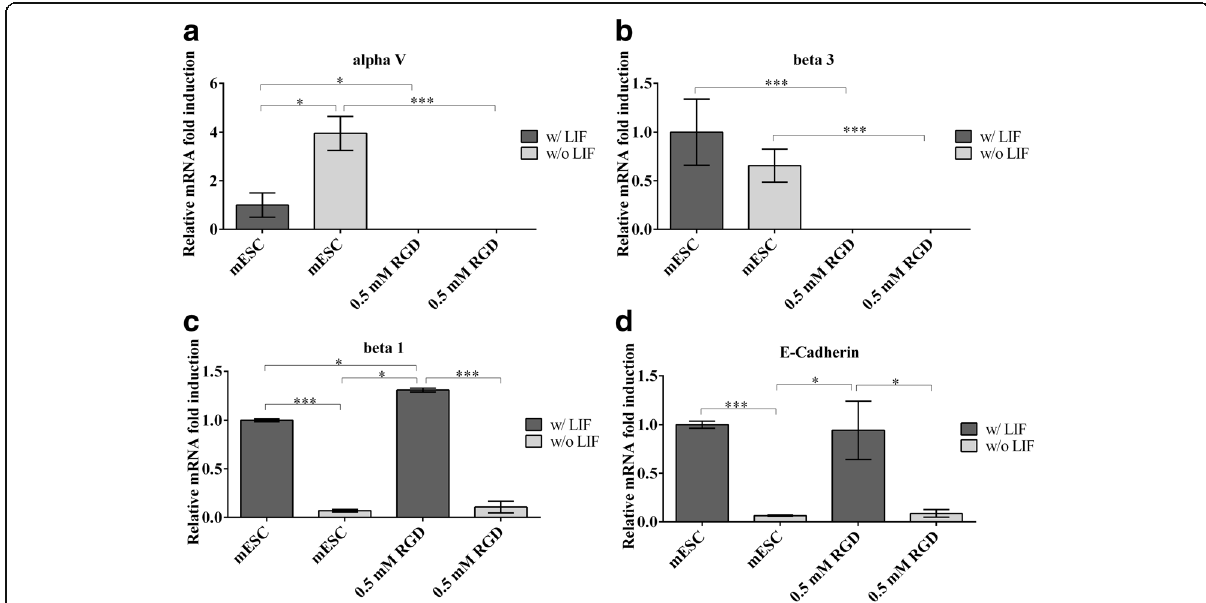
Fig. 6 Relative mRNA gene expression of cell surface receptors in the presence of cRGDfC, w/ and w/o LIF. Supplementation of cRGDfC shut down the expression of RGD dependent integrin subunits, ( a ) alphaV and ( b ) beta 3, independent of LIF. The expression of ( c ) beta 1 and ( d ) E-Cadherin appeared to be LIF dependent. In the presence of LIF beta 1 and E-Cadherin expression was up-regulated and without LIF down- regulated. Mean ± SD, n = 3 independent experimental replicates. (***;p < 0.0001; **;p < 0.001; *;p <